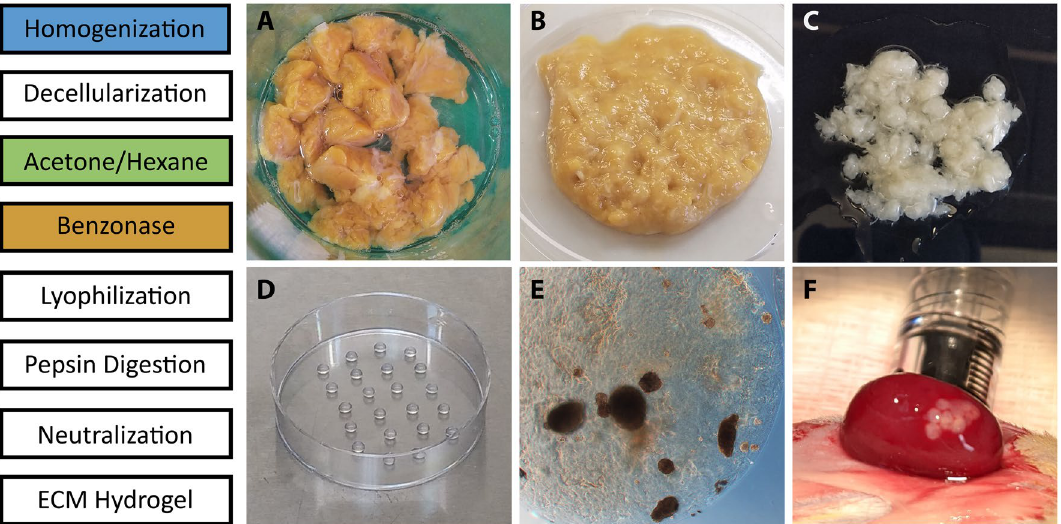
Figure 1. Protocol for the decellularization and gelation of human pancreas ECM. A schematic representation for the protocol to decell, digest and form a hydrogel from human pancreas ECM (left side). Images of the native tissue (A) , homogenized tissue (B) , decellularized and delipidized ECM (C) and multiple 5 μL hydrogel droplets in a 6 cm dish (D) . Human islets can be embedded in the hydrogel prior to gelation to form stable droplets for in vitro culture (E) ; the droplets are durable enough to maintain shape and consistency throughout the transplantation process (F)